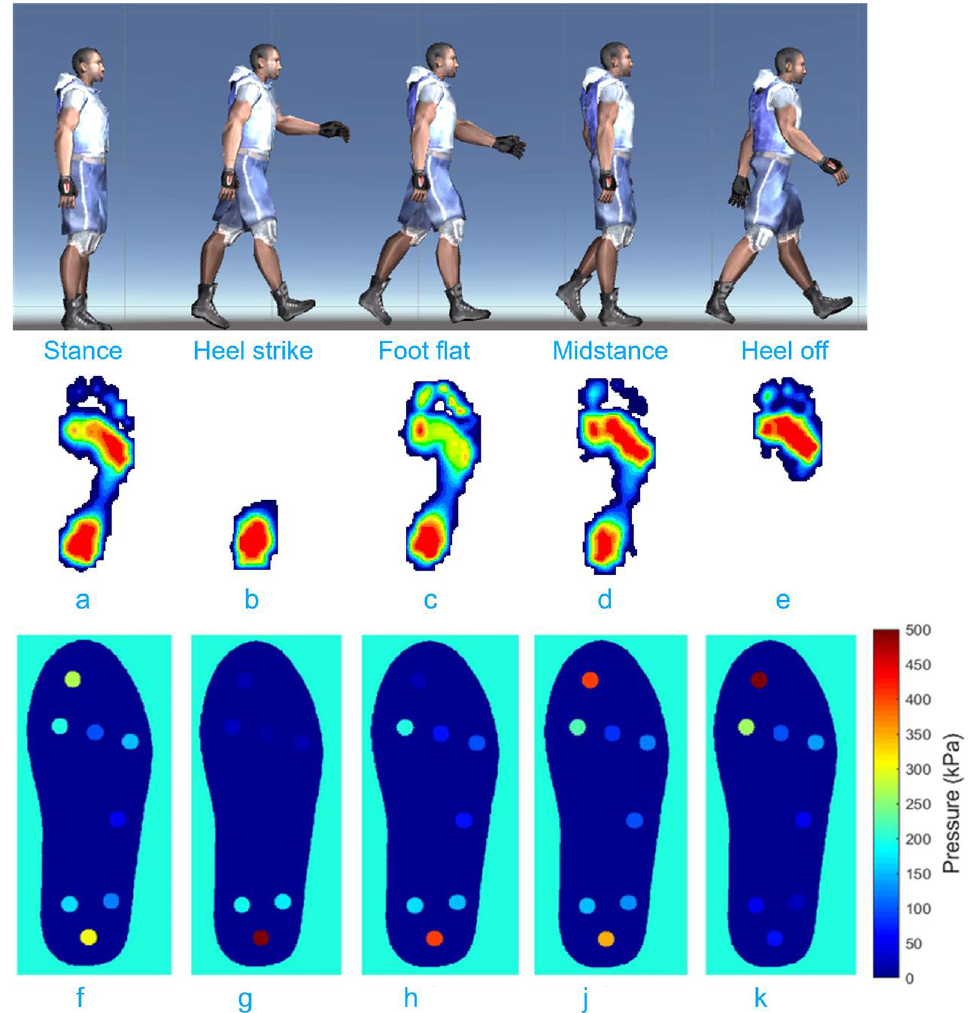
Figure 7. Plantar pressure distribution of the right foot during the main phase of one complete gait cycle. ( a – e ) reference images by a commercial pressure measurement device. ( f – k ) images obtained by the proposed design. Figure 7a – e are the images obtained from a commercial pressure measurement de- vice (Matscan system from Tekscan, Boston, MA, USA) [20]. Figure 7f – k are the images obtained using the proposed design. The pressure distribution maps displayed on the in- sole utilize the color range to represent fluctuations of pressure. The selected color range was between dark blue (lowest pressure) to dark red (highest pressure). In general, the bodyweight for individuals divided into two halves that spread evenly over two feet. In the standing position, the body weight will be evenly distributed over the foot and cov- ered most areas of it, as shown in Figure 7f.